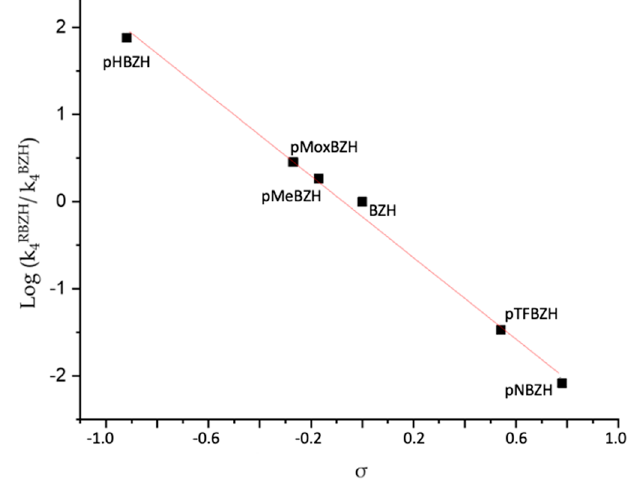
Figure 5. Graphical representation of the Hammett equation for k 4 , nucleophilic attack.